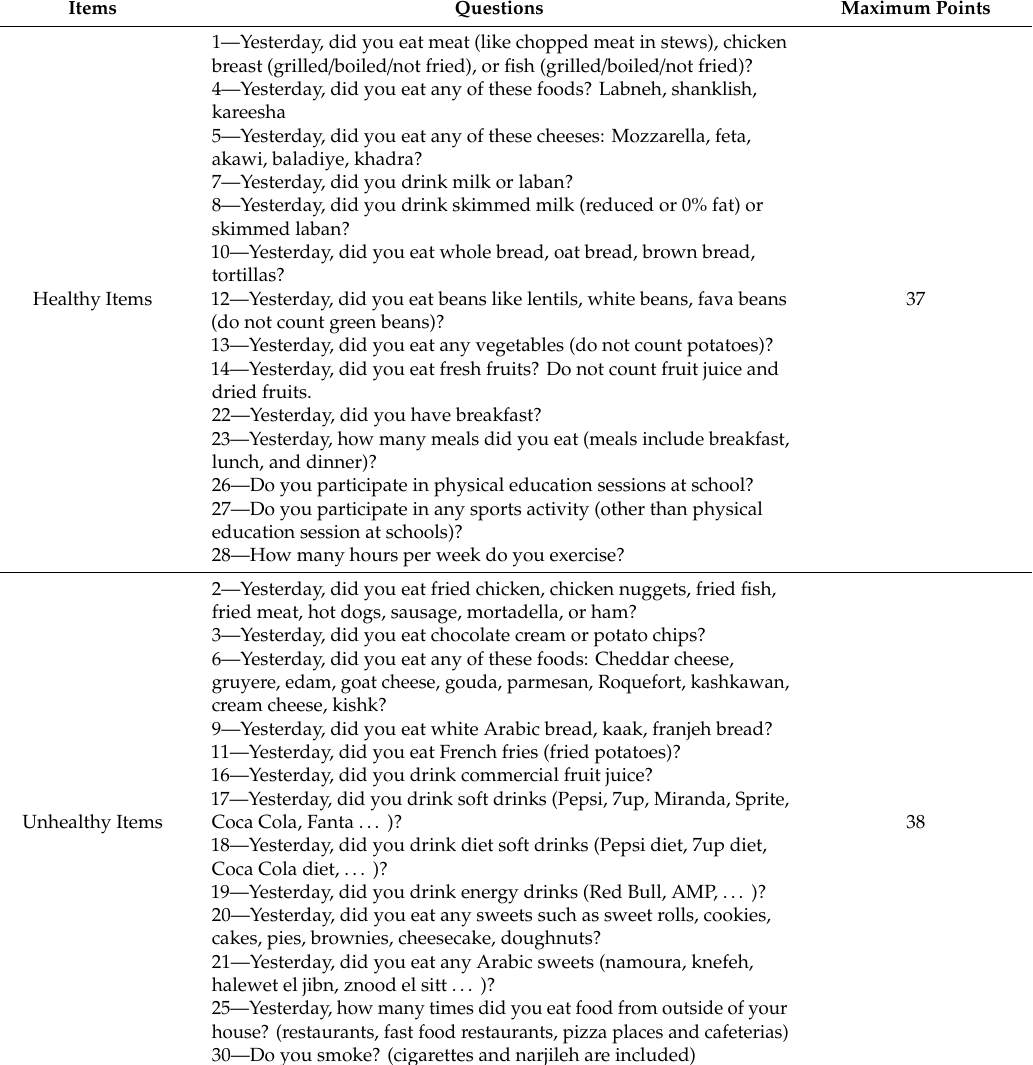
Table 1. Total adherence score components for